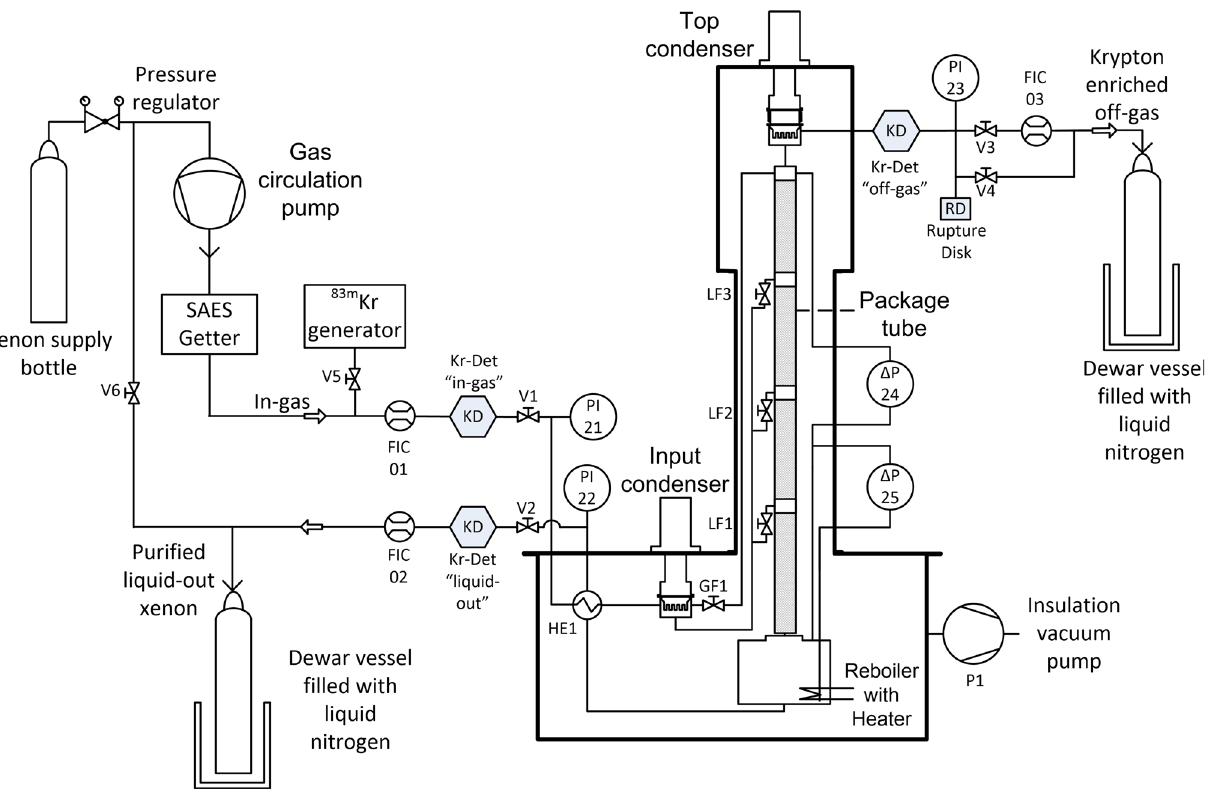
Fig. 3 P & I Diagram of the Phase-1 distillation setup. The xenon is injected from storage bottles to the distillation plant, while the purified xenon as well as the krypton enriched off-gas are collected into sepa-